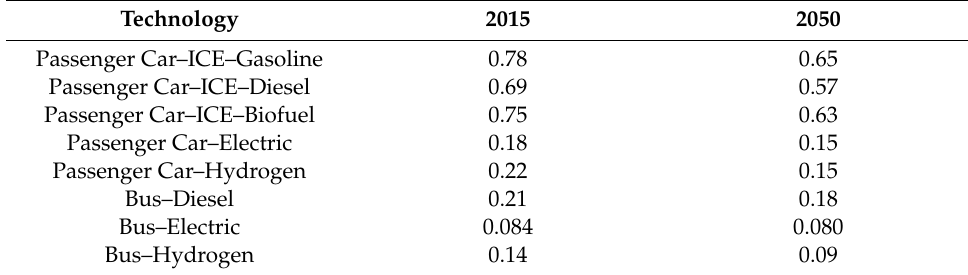
Table A13. Energy e ffi ciency of various vehicle types represented in TWh / gpkm. Data based on